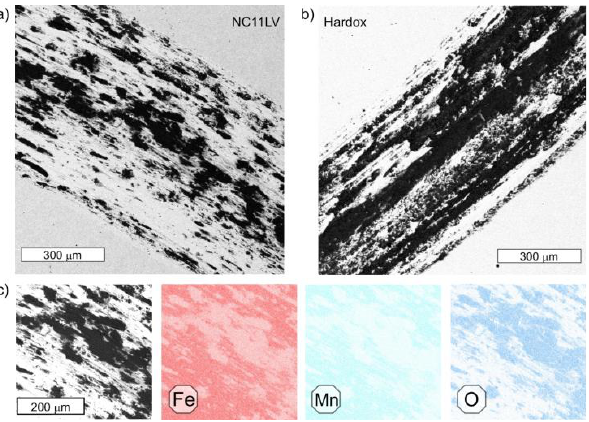
Figure 12. Microscopic SEM image: ( a ) obtained from the friction area for steel NC11LV and ( b ) obtained from the friction area for steel Hardox 600. ( c ) An enlarged fragment of the area in Figure 12a with the distribution of iron, manganese and oxygen. SEM/EDX.